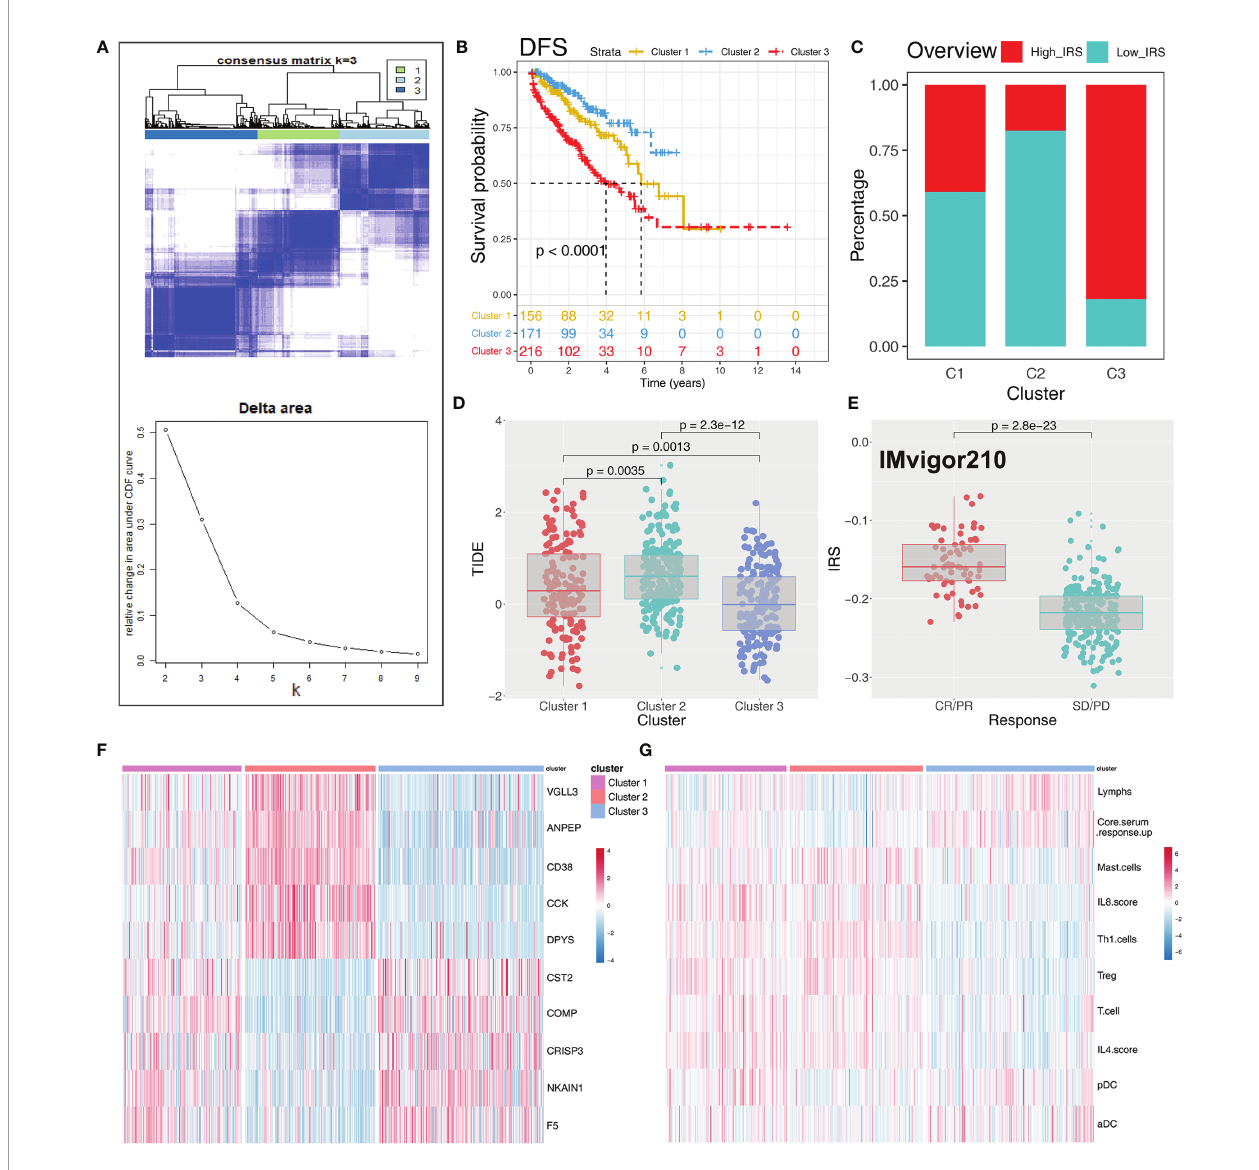
FIGURE 8 | Consensus clustering identi fi ed distinct IRS clusters with different DFS prognosis and immunotherapy response rate. (A) ConsensusClusterPlus package was used to distinguish IRS subgroups of PRAD with resamplings set as 1,000. The classi fi cation was optimized and clustered of samples into three subtypes. (B) Kaplan-Meier survival curve showed different prognosis characteristic in IRScluster1 – 3, among which cluster 2 had the best prognosis and cluster 3 had the worst. (C) The IRScluster1 – 3 had a different percentage of high IRS patients and the IRScluster5 had the most. (D) The TIDE difference in IRScluster1 – 3 and the IRScluster3 had the lowest TIDE value. (E) IRS difference in IMvigor210 dataset (CR/PR vs . SD/PD). CR, complete response; PR, partial response; SD, stable disease; PD, progressive disease. (F, G) The differential gene and immune in fi ltrating patterns were illustrated in heatmap across fi ve